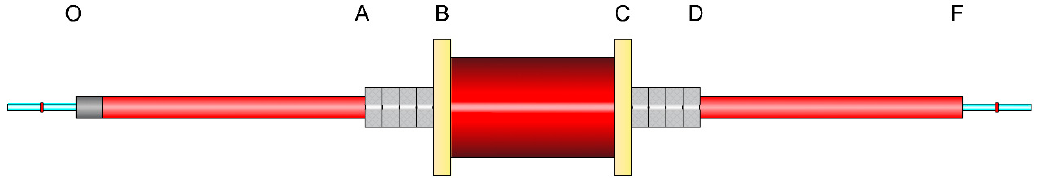
Figure 5. Strain recorded by DFOSs on simple bars (S1–S5) tested in the laboratory.